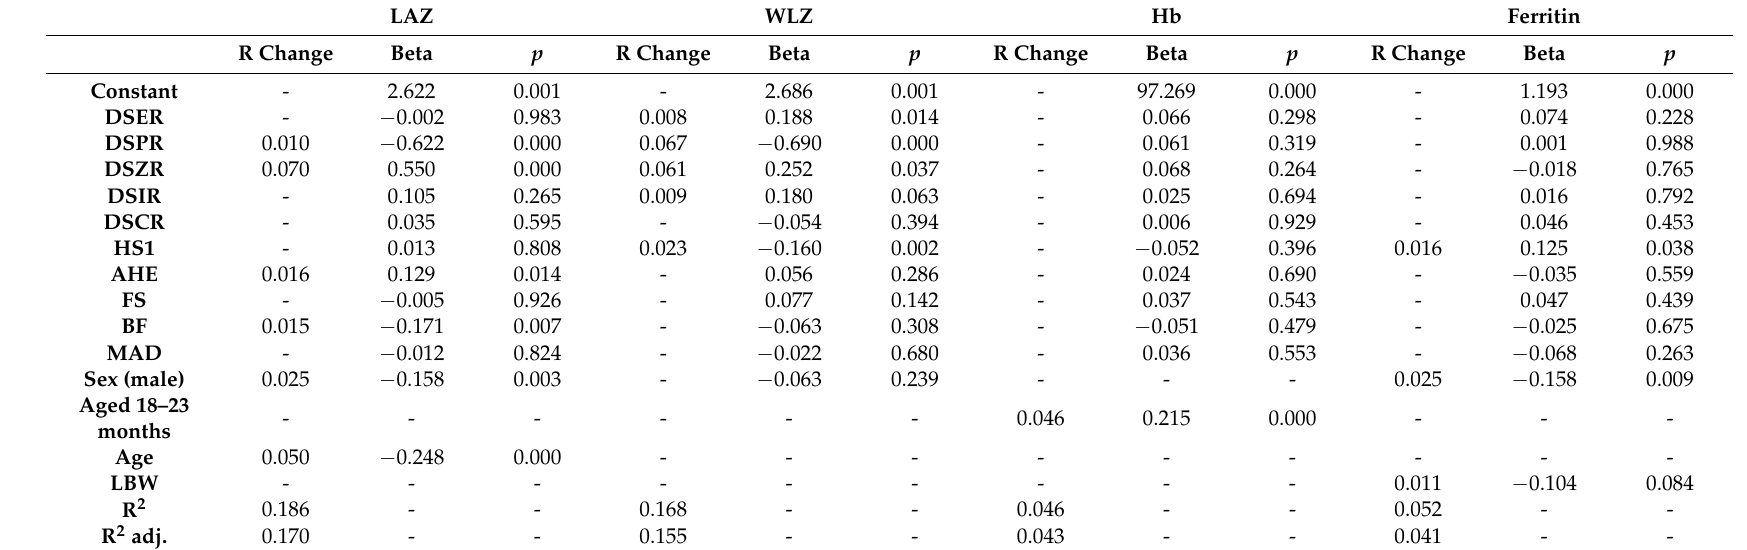
Table 5. Regression analyses of nutritional status (LAZ, WLZ, hemoglobin and ferritin) on its determinants ( n = 296) *: final